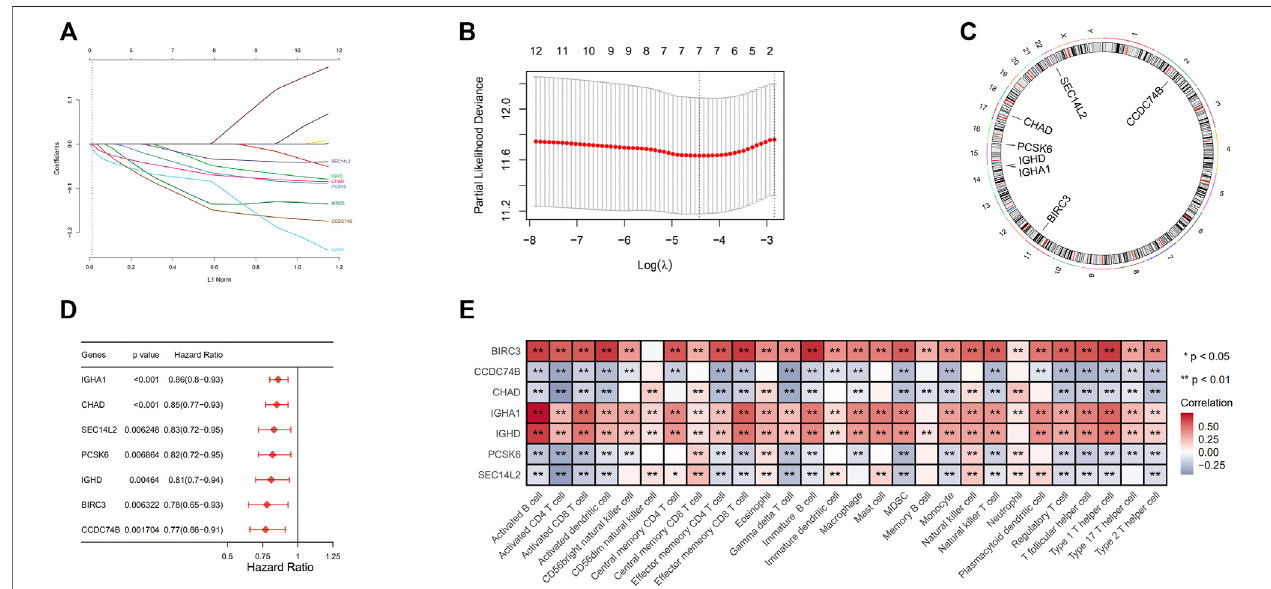
FIGURE3|(A) Theoptimalpenaltyparametervalueswerecon fi rmedby1,000roundcross-validation. (B) Sevenhubgenesrelatedtoprognosiswereanalyzedby LASSO Cox analysis. (C) Each of seven genes on chromosomes was shown in Circos plots. (D) The contribution made by each of the seven genes to survival differences. (E) Correlation matrix of immune cell in fi ltration and the expression levels of seven immune-associated genes.